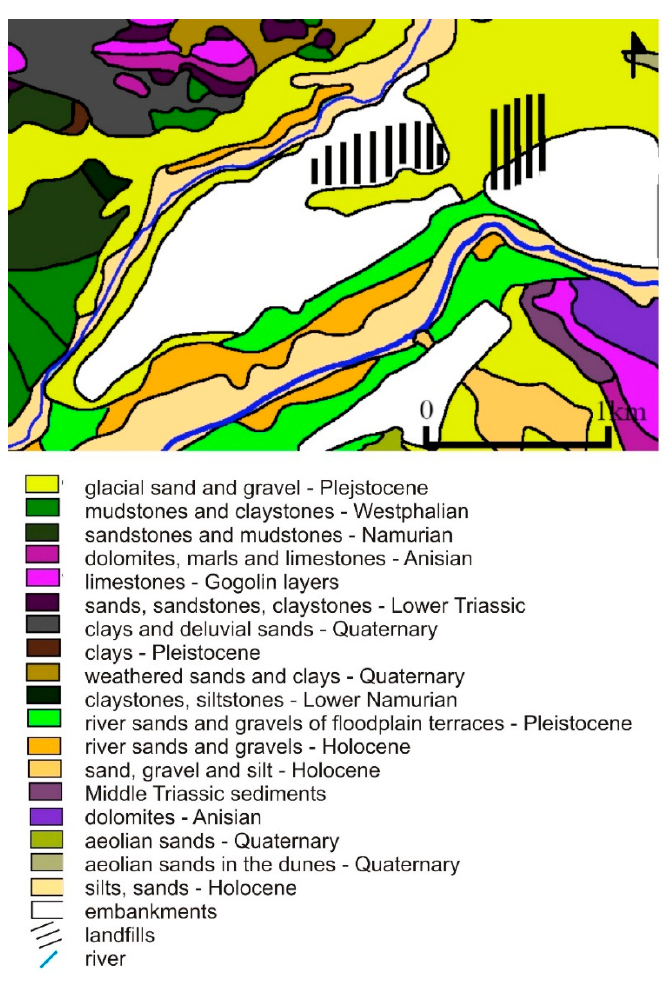
Figure 2. Geological map of the study area [30].